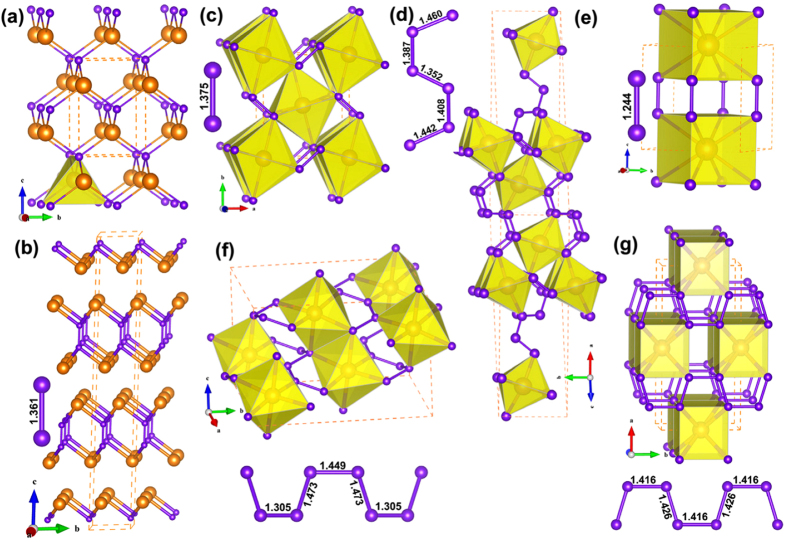
Crystal structures of Ru nitrides.(a) I-4m2-RuN with wyckoff position Ru (2d) (0, 0.5, 0.75) and N (2a) (0, 0, 0). (b) R-3m-RuN with wyckoff position Ru (6c) (0, 0, 0.2322) and N (6c) (0, 0, 0.0374). (c) Pnnm-RuN2 with wyckoff position Ru (2a) (0, 0, 0) and N (4g) (0.1236, 0.4058, 0). (d) P21/c-RuN3 with wyckoff position Ru1 (4e) (0.5011, 0.1336, 0.1479), Ru2 (4e) (0.0313, 0.6289, 0.8824), N1 (4e) (0.6973, 0.3548, 0.1936), N2 (4e) (0.2439, 0.2475, 0.1333), N3 (4e) (0.3172, 0.9829, 0.1262), N4 (4e) (0.8148, 0.8595, 0.8150), N5 (4e) (0.2560, 0.7440, 0.8680) and N6 (4e) (0.1891, 0.4645, 0.8779). (e) P4/mmm-RuN4 with wyckoff position Ru (1c) (0.5, 0.5, 0) and N (4i) (0, 0.5, 0.3279). (f) C2/c-RuN4 with wyckoff position Ru (4e) (0, 0.0915, 0.25), N1 (8f) (0.2863, 0.0884, 0.6852) and N2 (8f) (0.3372, 0.2646, 0.2598). (g) Cmmm-RuN4 with wyckoff position Ru (2b) (0, 0.5, 0) and N (8q) (0.1606, 0.1930, 0.5). The Ru and N atoms are represented as big orange and small purple spheres, respectively.